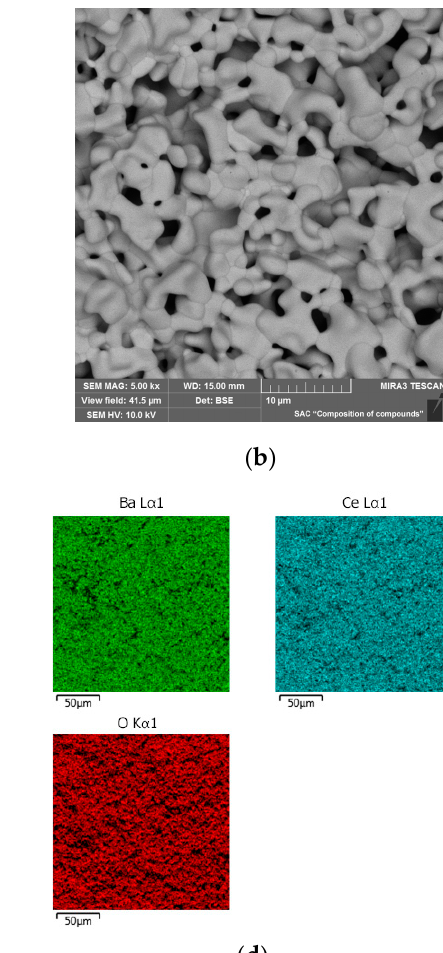
( d ) Figure 3. BCGCuO film structure on the LNO cathode (1450 °C, 2 h): ( a ) film surface; ( b ) distribution of the elements in the film/substrate system in dependence on the distance from the film surface and EDX mapping image: ( c ) integrated; ( d ) individual elements. Based on the results obtained, we switched to another method for preserving barium in the BCGCuO film, namely, the application of a BCO protective film over the BCGCuO electrolyte film (the second experiment (2)). The two-layer BCGCuO/BCO film was formed according to the following scheme: first, BCGCuO layers were obtained by cyclic EPD according to the mode described above (five cycles with intermediate sintering at 900–1350 ° С and final sintering at 1400 ° С , 2 h) and then BCO layers were deposited onto the BCGCuO film (five cycles with intermediate